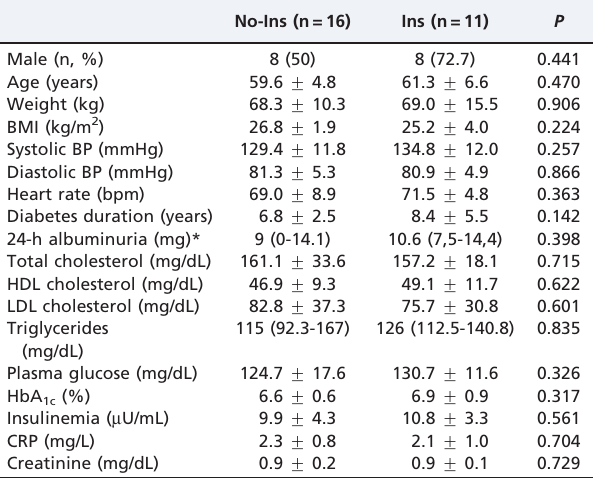
Table 1 - Baseline clinical and laboratory characteristics by group.